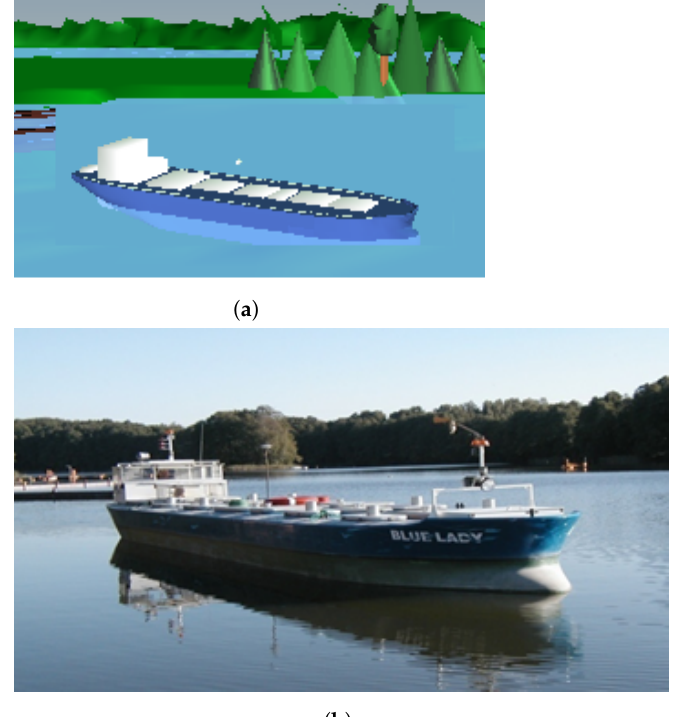
Figure 1. ( a ) Blue Lady 3D ship model. ( b ) Actual Blue Lady ship model on Silm lake. Ship parameters: Lenght 13.75 [m], width 2.38 [m].